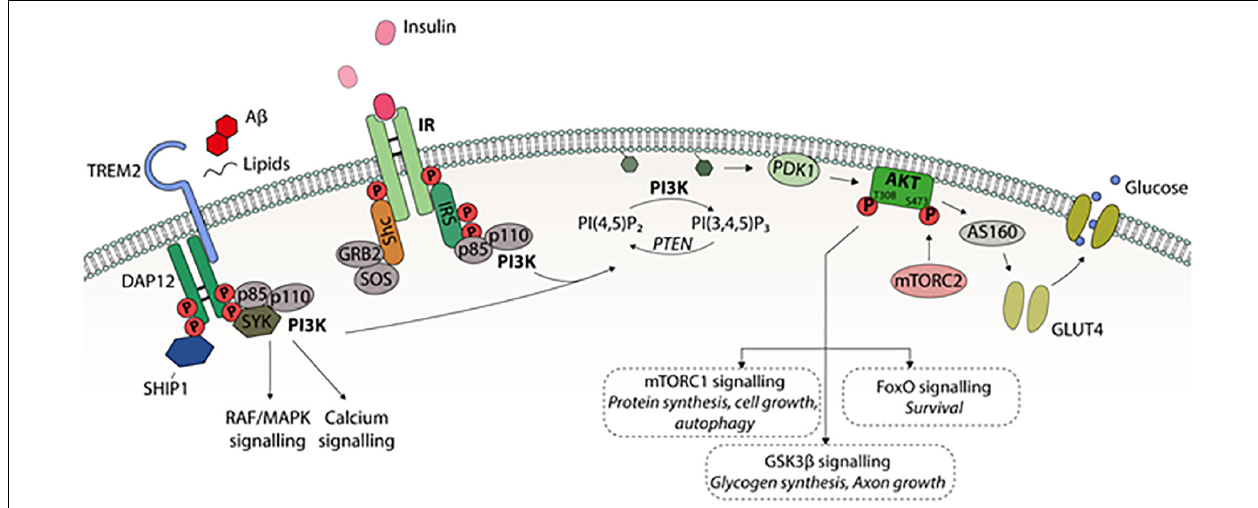
FIGURE 1 | A schematic presentation of PI3K-Akt intracellular signaling. Different extracellular stimuli, e.g., growth factors mediate their effects by receptors belonging to receptor tyrosine kinase (RTK) family locating in the cell membrane. Binding of insulin to IR leads to activating tyrosine phosphorylation of insulin receptor substrate (IRS). This activates phosphatidylinositol-4,5-bisphosphate 3-kinase (PI3K) consisting of regulatory p85 and catalytic p110 subunits. PI3K converts phosphatidylinositol (3,4)-bisphosphate (PIP 2 ) into phosphatidylinositol (3,4,5)-trisphosphate (PIP 3 ), which recruits Akt-kinase to cell membrane. PIP 3 activates phosphoinositide-dependent protein kinase 1 (PDK1) to phosphorylate threonine 308 site in Akt1. For the full activation of Akt, serine 473 phosphorylation by mammalian target for rapamycin complex 2 (mTORC2) is needed. PI3K-Akt pathway regulates several cellular functions via downstream factors; Akt